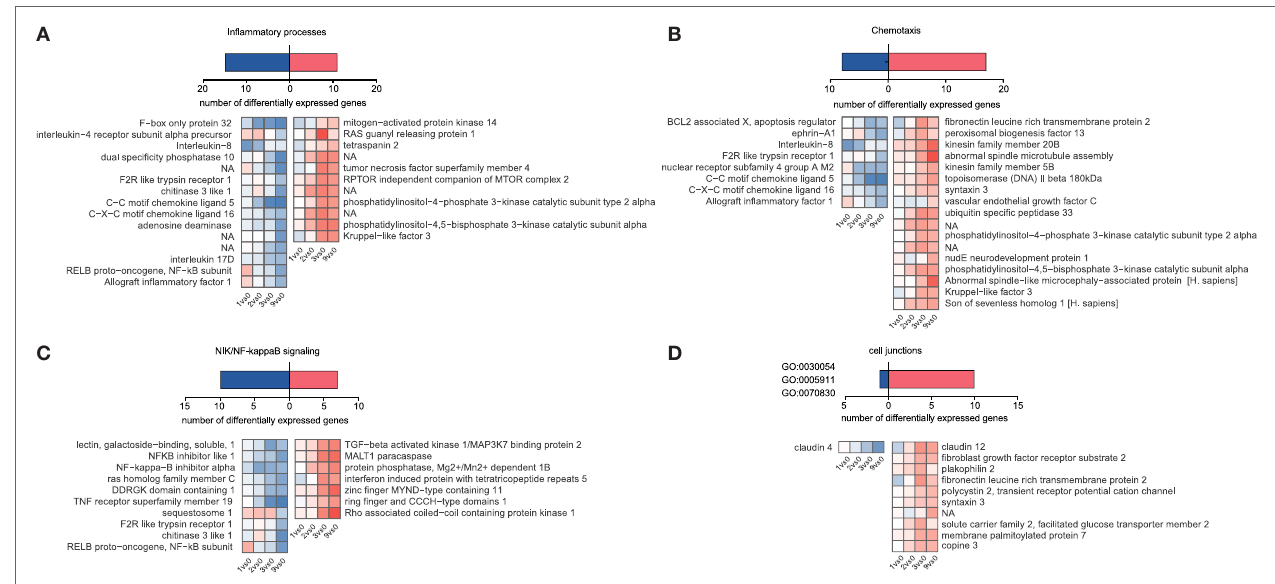
FigUre 4 | Temporal gene expression changes in porcine intestinal epithelial cells in response to A. suum larvae. Blastp, Blast2GO, and InterProScan were used to identify S. scrofa differentially expressed genes associated with distinct immune responses or cell junction for (a) “Inflammatory processes,” (B) “Chemotaxis,” and (c) “NIK/NF-kappaB signaling.” For (D) “Cell junctions,” the cell–cell junction localization filter was manually selected for GO:0030054, GO:0005911, and